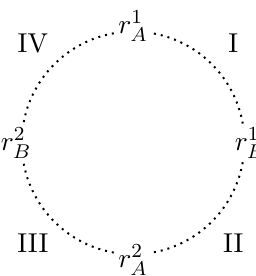
Figure 7. A depiction of any graph which is not weakly separated. The dots refer to any distri- bution of other subset